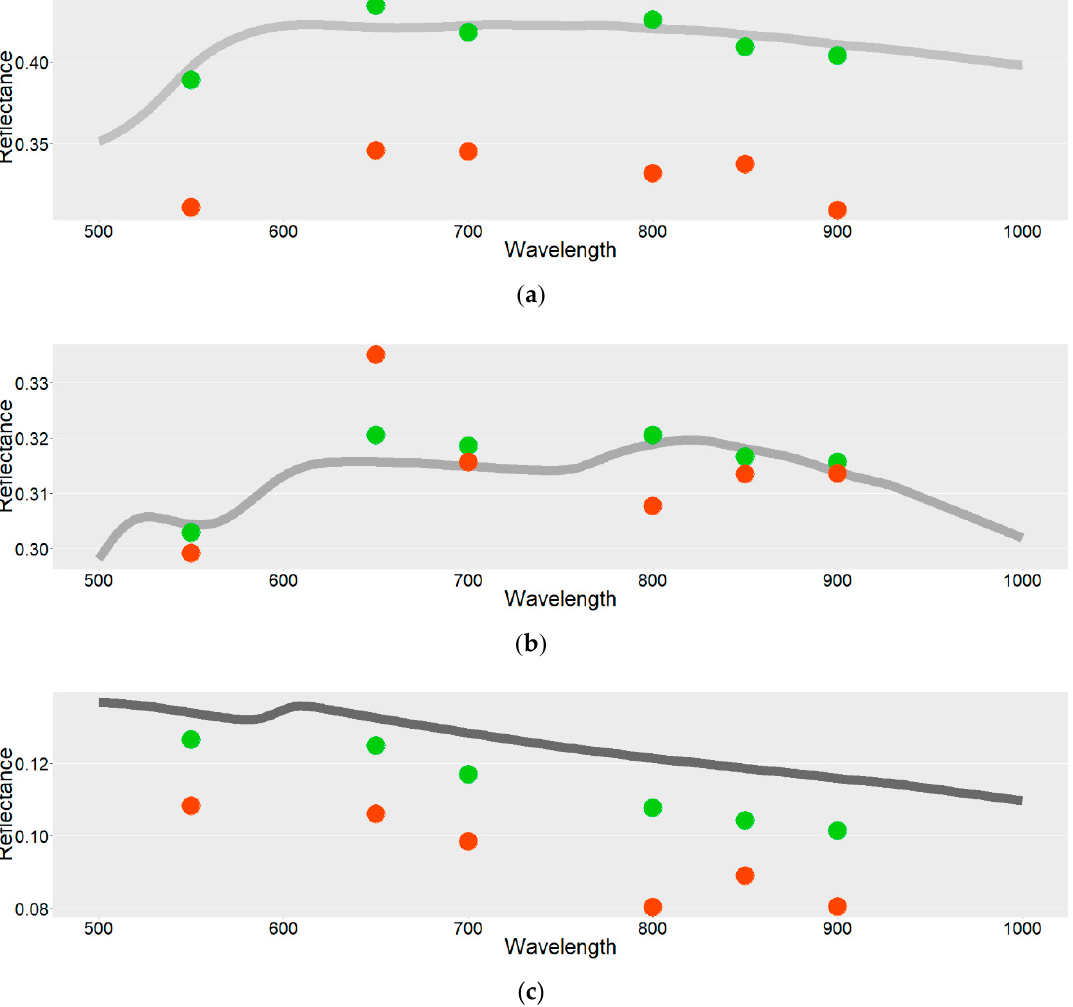
Figure 19. The comparison of thee validation target reflectance curves: ( a ) Pearl 4; ( b ) Light Grey 5; ( c ) Medium Grey 7 (see Figure 5) derived from a spectrometer measurement with median reflectance values of the same targets extracted from raw (red dots) and corrected (green dots) image.